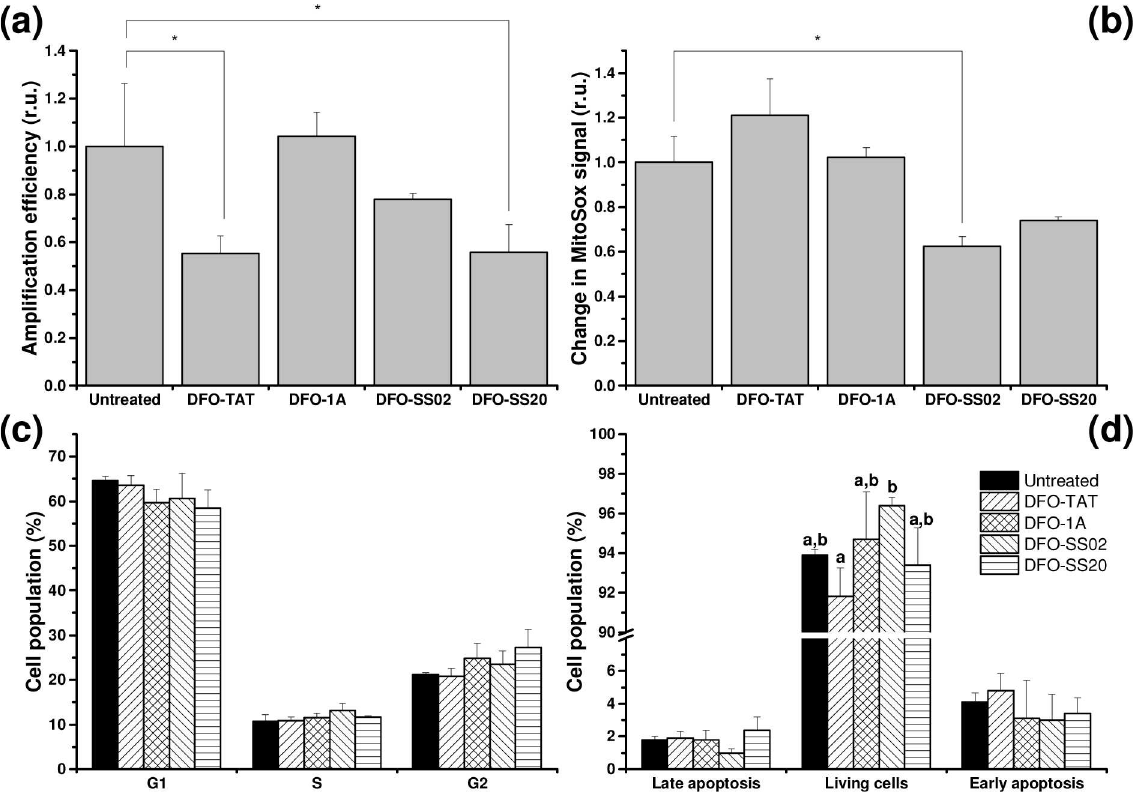
Fig 5. Cellular effectson A2780cells treated with ½ IC 50 of the mtDFO. (a) mtDNA amplification. (b) Productionof mitochondrial superoxide. (c) Cell cycle arrest. (d) Apoptosistested by the AnnexinV method. r.u. = relative units; * : statisticallysignificant differences in relationto untreated controls (P < 0.01). Different letters indicatesignificantdifferencesin relationto untreatedcontrols after one way ANOVA (P <